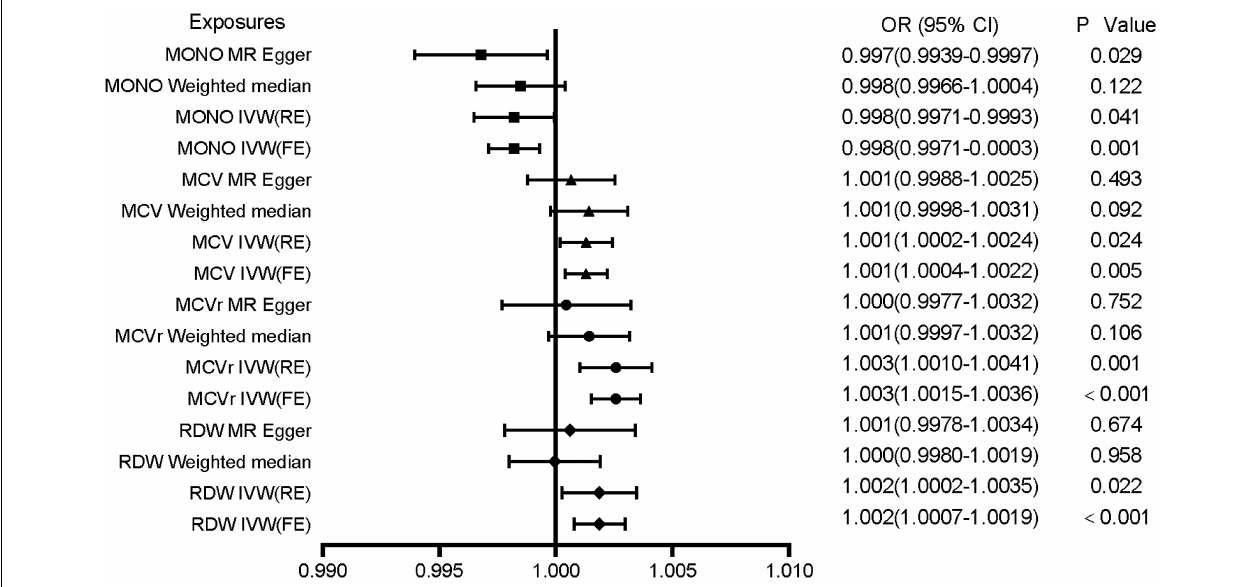
FIGURE 2 | Associations of genetically predicted MONO, MCV, MCVr, and RDW with VTE. MONO, monocyte count; MCV, mean corpuscular volume; MCVr, mean corpuscular volume of reticulocyte; RDW, red blood cell distribution width; OR, odds ratio; CI, confidence